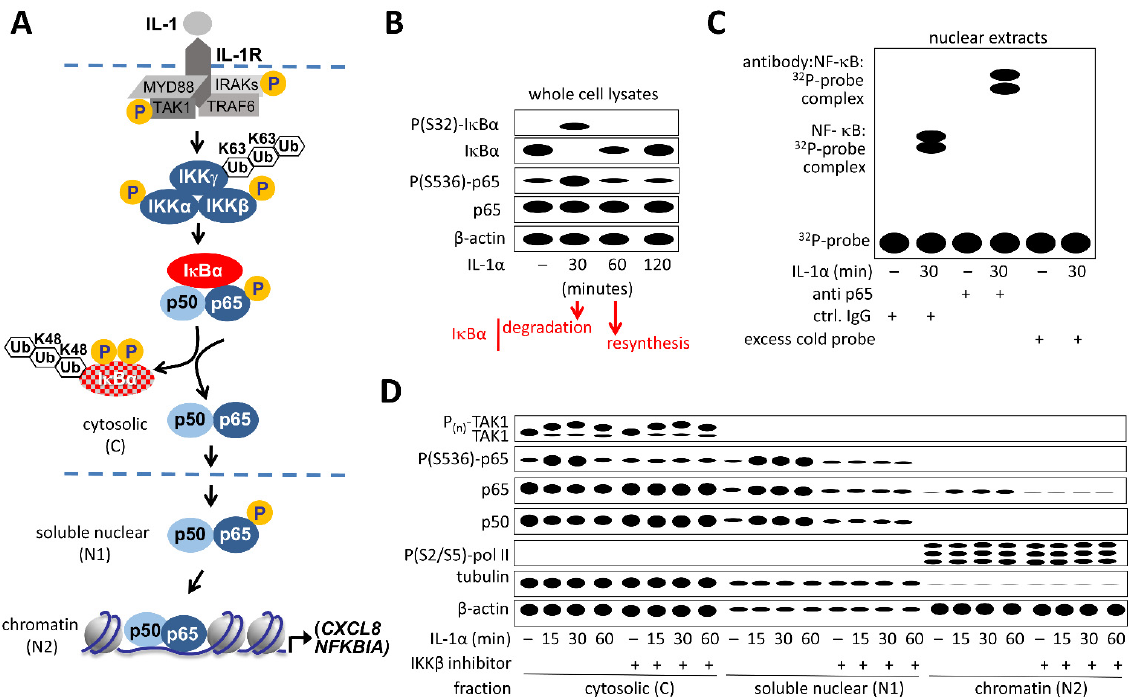
Figure 3. Key assays to determine NF- κ B activation. ( A ) Overview of components and steps of NF- κ B activation that can be monitored in cell extracts. ( B ) Typical pattern of protein bands observed by Western blot analysis of whole cell extracts of IL-1 α -treated HeLa cells. A prototypical Western blot result of this kind is presented in Appendix Figure S5 of [62]. ( C ) Typical patterns of NF- κ B protein complexes bound to labelled double-stranded oliogonucleotides containing NF- κ B sites in vitro. Nuclear extracts from untreated and IL-1 α -treated cells are mixed with probes and the resulting complexes are resolved by electromobility shift assays (EMSAs). The identity of proteins and the specificity of DNA binding is further determined by addition of NF- κ B-specific antibodies (resulting in supershifts) and by competition of signals with unlabeled (“cold”) oligonucleotide probes. The EMSA is very sensitive to detect nuclear translocation of NF- κ B upon cellular activation, but does not reveal the native genomic binding sites and targets as compared to ChIP. For typical EMSA results see [63,64]. ( D ) Subcellular distribution of NF- κ B subunits determined by Western blotting of cytosolic, soluble nuclear and insoluble (chromatin-associated) fractions. The scheme shows the patterns of protein bands demonstrating that in IL-1 α -activated KB cells (a HeLa subclone) around 30–50% of total p65 is rapidly translocated to the nucleus and a small part is stably associated with chromatin. In the same extracts, p105 processing is assessed by detecting p50, which also translocates to the nucleus. The addition of an IKKß-specific inhibitor (PHA-408) results in suppression of IL-1 α -inducible (but not constitutive) p65 phosphorylation at Ser536 as well as inducible nuclear translocation of both, p65 and p50. In line with the model shown in ( A ), IKKß inhibition does not affect the activation of the upstream kinase TAK1, as determined by retarded electrophoretic mobility of the multi-site phosphorylated forms P (n) . For the original Western blots and quantification of the relative amounts of NF- κ B subunits before and after activation, see Figure S4 of [65]. This type of experiment provides comprehensive and quantifiable information on multiple steps of NF- κ B activation, but requires large numbers of cells and takes relatively